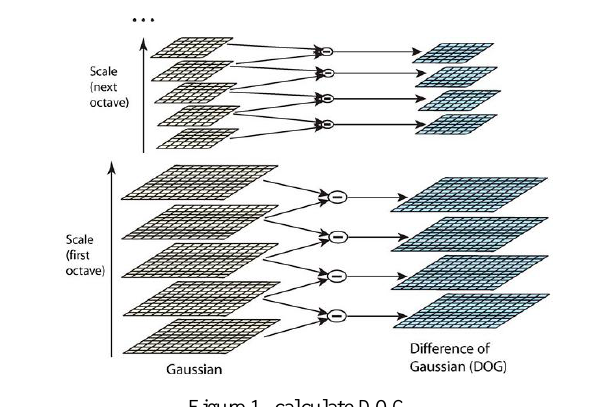
Figure 1. calculate